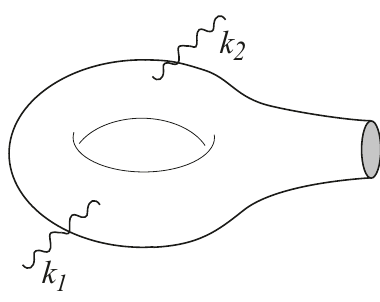
Figure 2 . Genus-3/2 amplitude leading to logarithmic correction to the induced 4d Planck